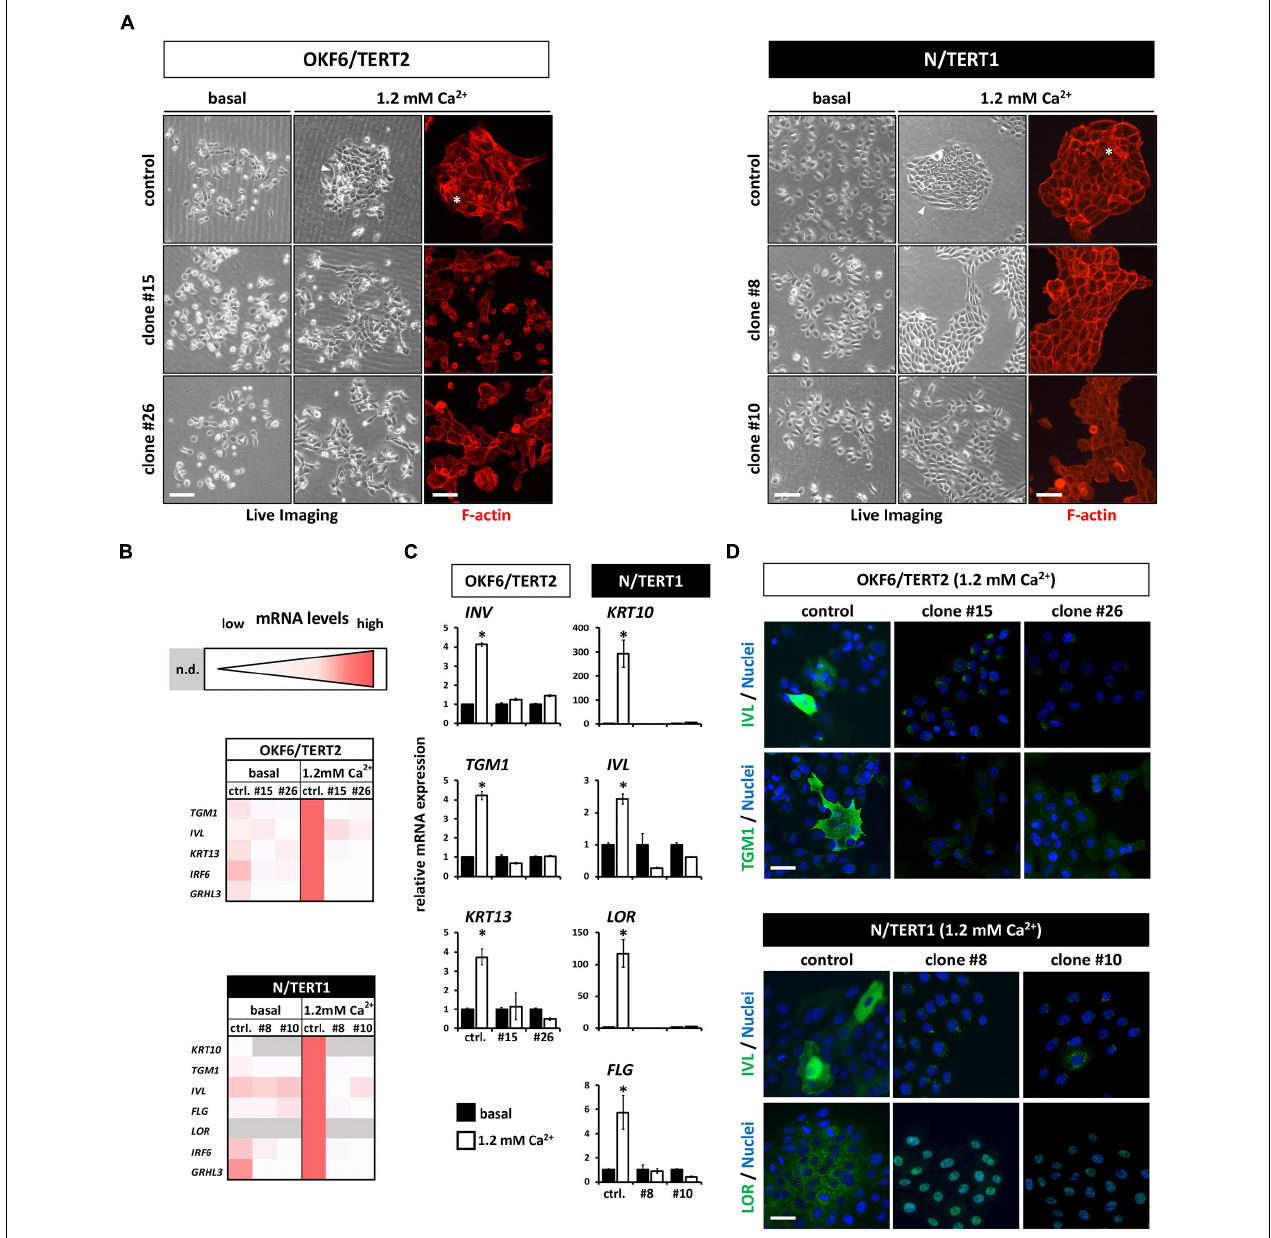
FIGURE 5 | (A) Live Imaging pictures and F-actin staining (phalloidin, red) with or without (only Live Imaging) exogenous Ca 2 + addition. While the control keratinocytes start to differentiate (asterisk and arrowheads), lack of IRF6 impairs differentiation. Scale bar: 200 µ m (Live Imaging); Scale bar: 150 µ m (F-actin). (B) Heatmaps of the qPCR analyses of various differentiation markers in basal (0.1 mM) vs. high Ca 2 + (1.2 mM) conditions. Note that in the absence of IRF6 all the differentiation markers are not induced upon the Ca 2 + -switch. n.d.: not detectable (Ct > 32); ctrl.: control. (C) qPCR analyses of specific differentiation markers showing the lack of induction upon the addition of Ca 2 + in the IRF6 knockout clones compared to controls. ∗ p < 0.05 basal vs. 1.2 mM Ca 2 + . ctrl.: control. (D) Immunofluorescent staining for the markers Involucrin (IVL, green) and Transglutaminase 1 (TGM1, green) in OKF6/TERT2 cells and for IVL (green) and Loricrin (LOR, green) in N/TERT1 keratinocytes. Note that all differentiation markers were robustly induced in the control cells in the presence of IRF6. Scale bar: 50 µ m. DAPI was used to counterstain the cell nuclei (blue).